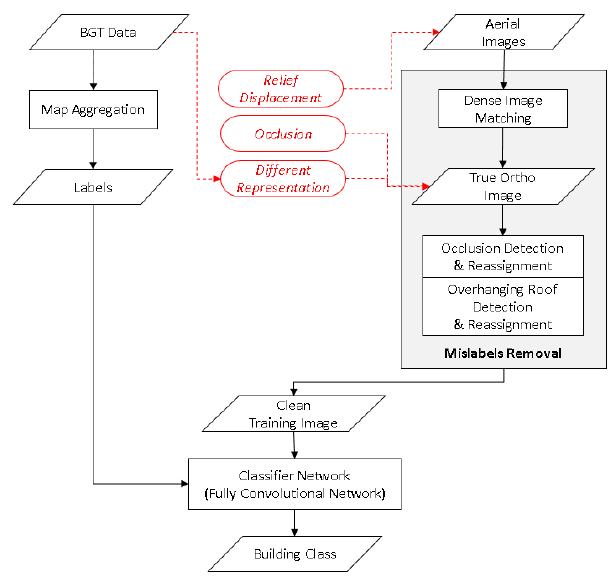
Figure 3. The Research Workflow